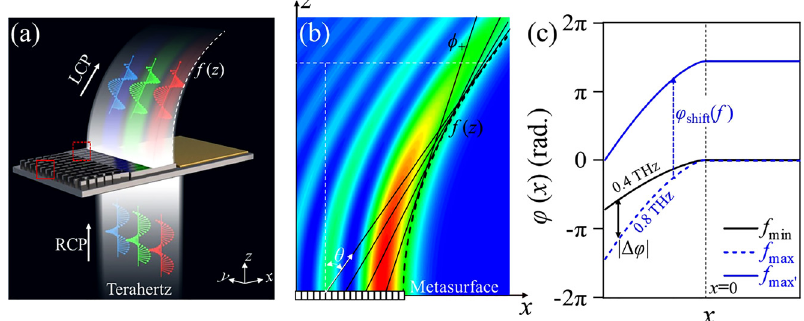
Figure 1: Schematic and phase profile of an achromatic Airy beam. (a) Schematic of the experimental generation of terahertz (THz) achromatic Airy beams by a silicon metasurface. The transmitted left circular polarization (LCP) THz intensities in the x – z plane fi t the parabolic trajectory f ( z ) for the right circular polarization (RCP) incident light. (b) To determine the phase distribution φ ( x , f ) of the metasurface under design, we draw an auxiliary line (black solid line) tangent to the parabolic asymptotical trajectory f ( z ) of the desired Airy beam (black dash line) at an arbitrary point, which intersects with x axis exhibiting an angle θ . With θ ( x ) function obtained by repeating such a process, we then obtain φ ( x , f ) based on Eq. (1). (c) Phase pro fi le of an achromatic Airy beam (cid:2) 820 ∘ at 0.8 THz, and the arbitrary transverse scale within the frequency range f ∈ [ f min , f max ] , where f min (cid:2) 0 . 4 THz, f max (cid:2) 0 . 8 THz, φ shift x 0 = 650 µm in our